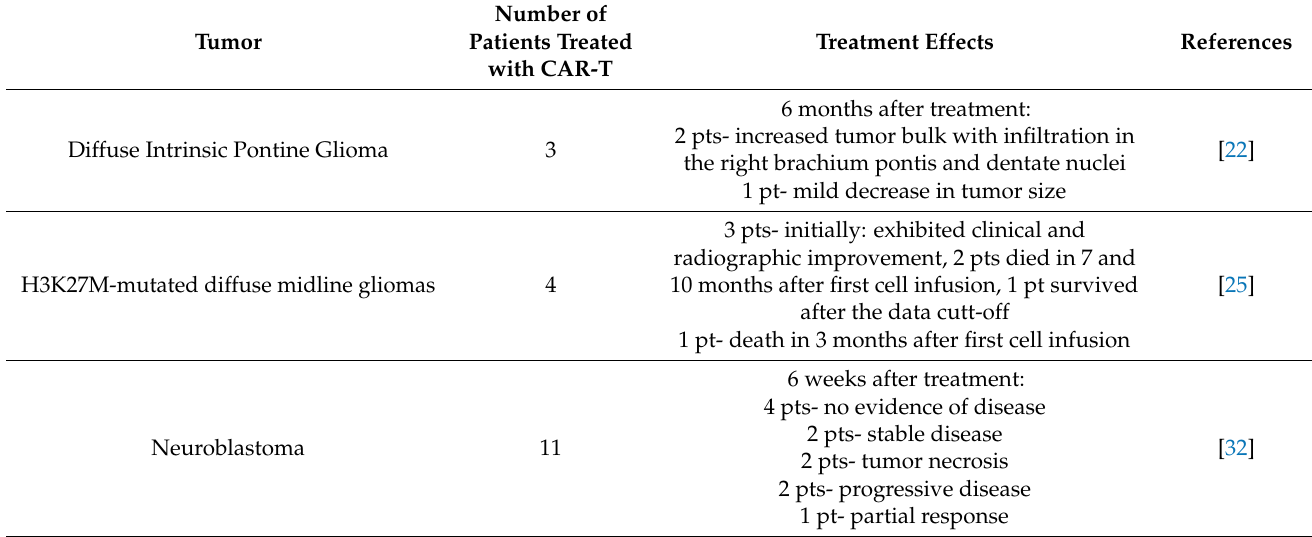
Table 1. Available studies on CAR-T efficacy in pediatric solid